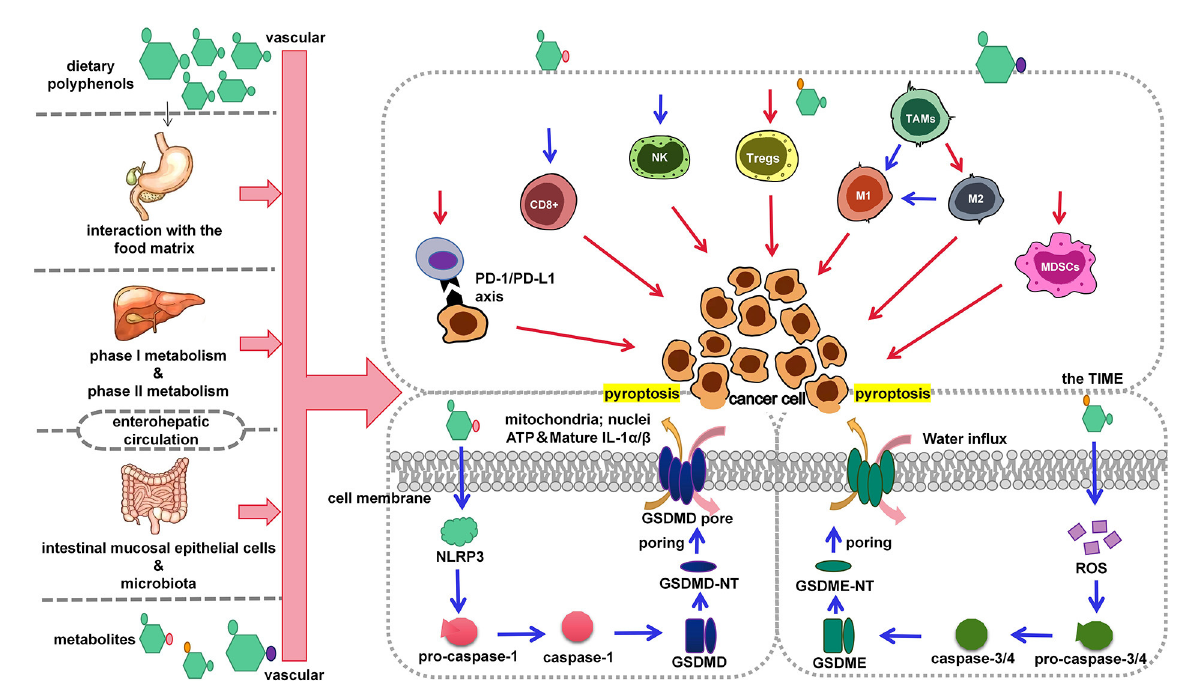
FIGURE1 Regulation of dietary polyphenols on cancer cell pyroptosis and the TIME. Dietary polyphenols are ingested orally and interact with food in the stomach. Subsequently, dietary polyphenols undergo phase I and phase II metabolism in the liver. In the gut, dietary polyphenols are metabolized and absorbed by intestinal epithelial cells and gut microbes. The absorbed and digested dietary polyphenols then travel with the blood to the TIME. Immune cells in the TIME are influenced by dietary polyphenols. At the same time, cancer cell pyroptosis was activated by dietary polyphenols. The blue arrow represents promotion and the red arrow represents